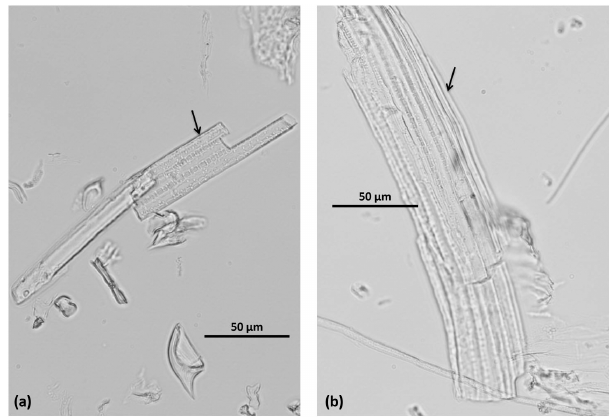
Figure 7. Micrographs of fragile phytogenic Si structures (arrows) of C. epigejos (a) and P. australis (b)